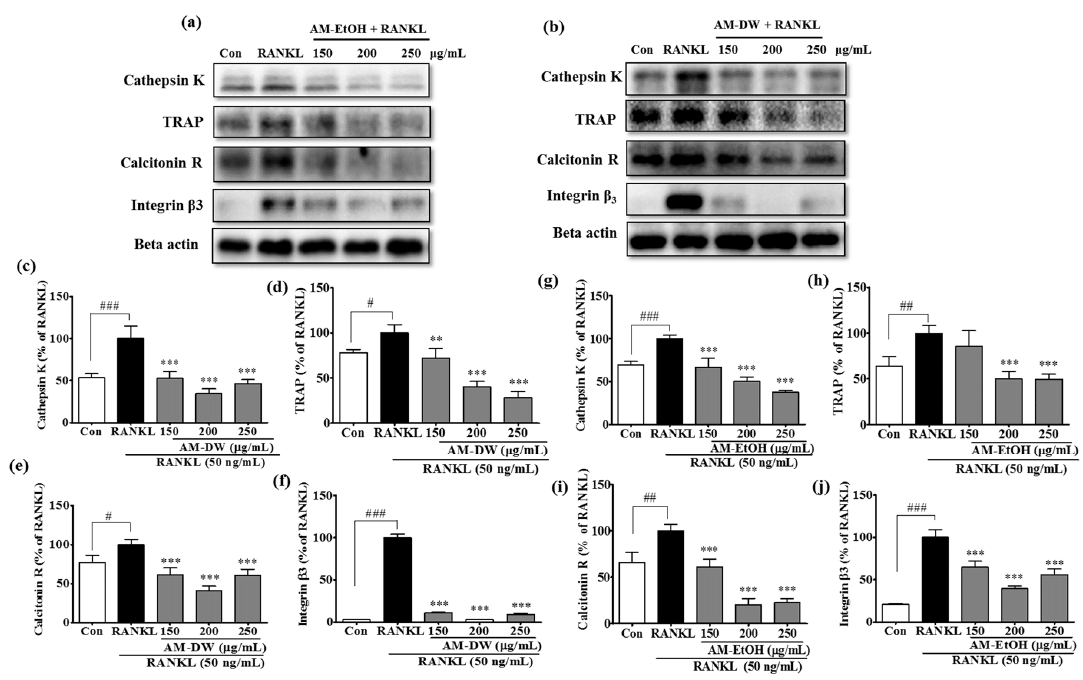
Figure 8. Inhibitory effects on gene expression of Cathepsin K, TRAP, Calcitonin receptor, Integrin β 3 during RANKL induced osteoclast in RAW 264.7 cells by AM extracts. ( a , b ) AM extracts inhibited the expression of Cathepsin K, TRAP, Calcitonin receptor, Integrin β 3 ; ( c – j ) Band intensities for Cathepsin K, TRAP, Calcitonin receptor, Integrin β 3 as percentages of the RANKL treated group (set as 100%), respectively. RANKL treated group was considered as 100% for densitometric analysis. Cells were exposed to RANKL (50 ng/mL) in the presence and absence of AM extracts for 3 days. The protein expression was determined by Western blot analysis and Beta actin was used as loading control. All data are presented as the mean ± SD of three independent experiments performed with n = 3. ** p < 0.01, *** p < 0.001 vs. RANKL treated group; and # p < 0.05, ## p < 0.01, ### p < 0.001 vs. Con group. Con; positive control, (which was not treated), RANKL; negative control, (which was treated with only RANKL).